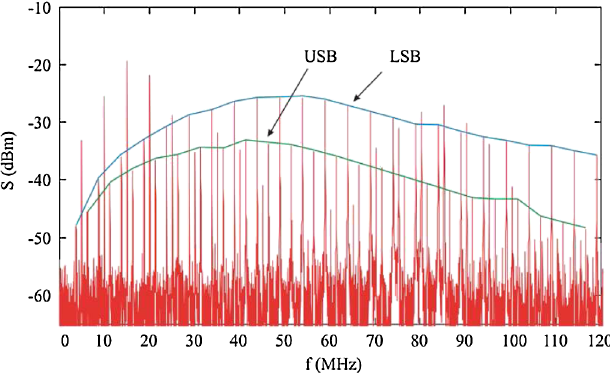
FIG. 3. (Color) The moment when the BPM data time window was taken for the FFT